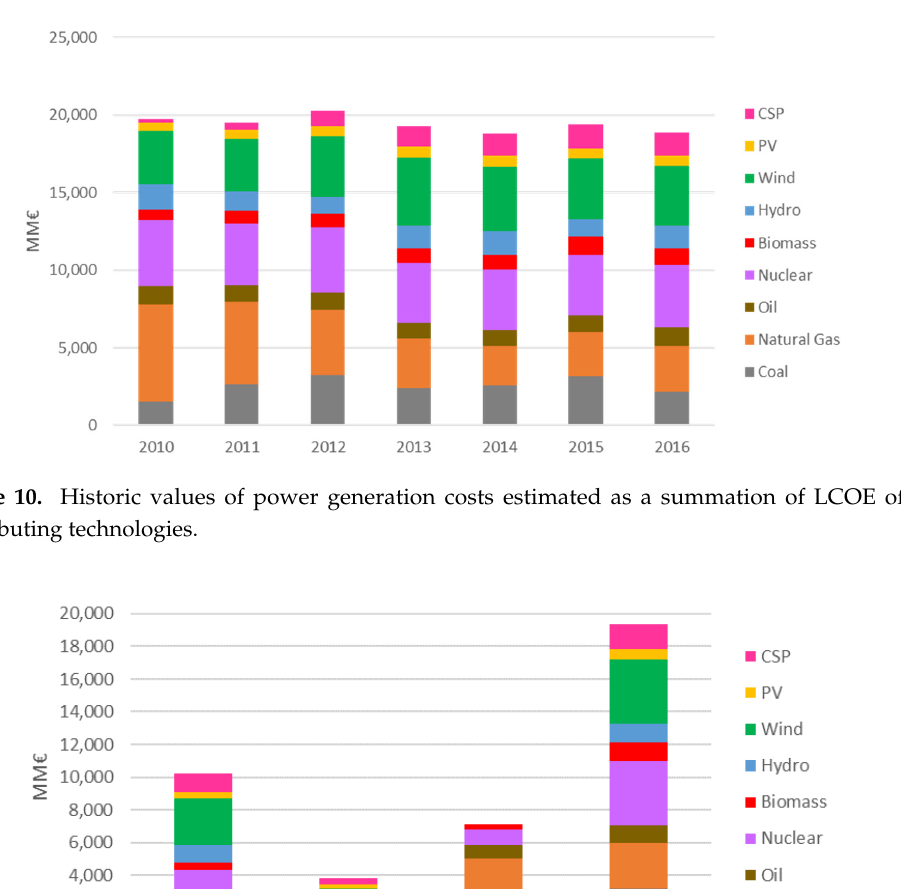
Figure 10. Historic values of power generation costs estimated as a summation of LCOE of all contributing technologies.